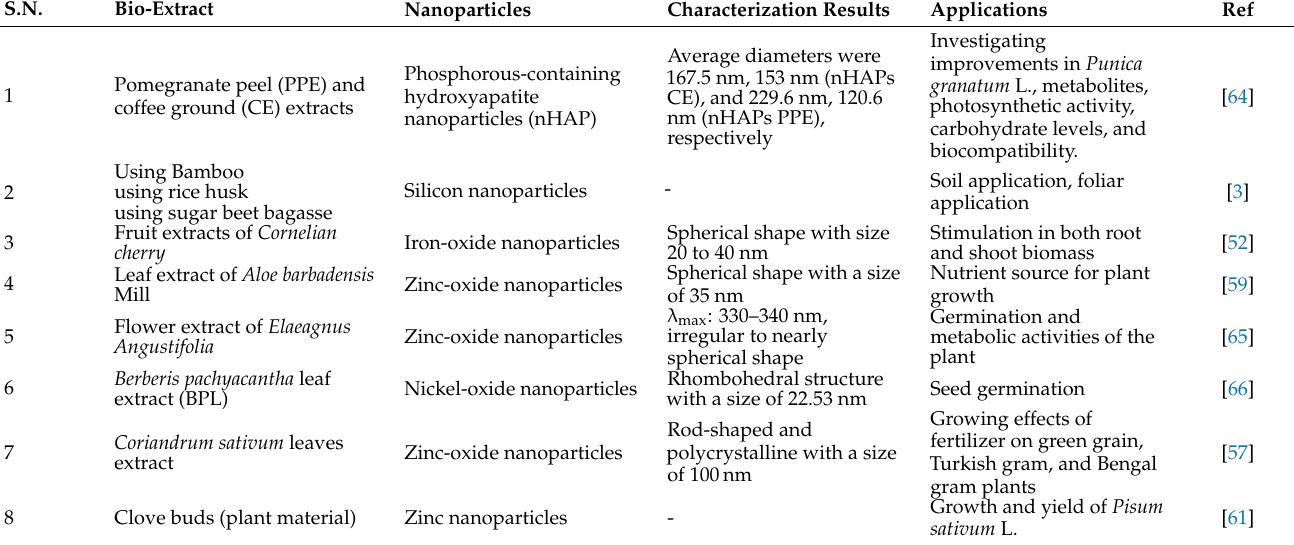
Table 2. Green synthesis of nanofertilizers using different plant